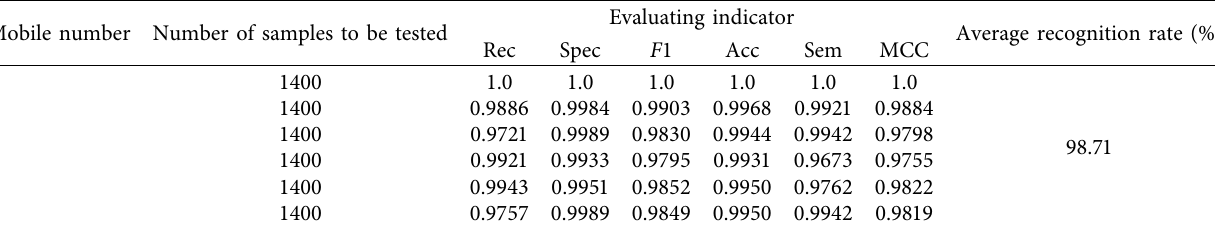
Table 2: Stacking individual identification results of mobile devices. Evaluating indicator Mobile number Number of samples to be tested